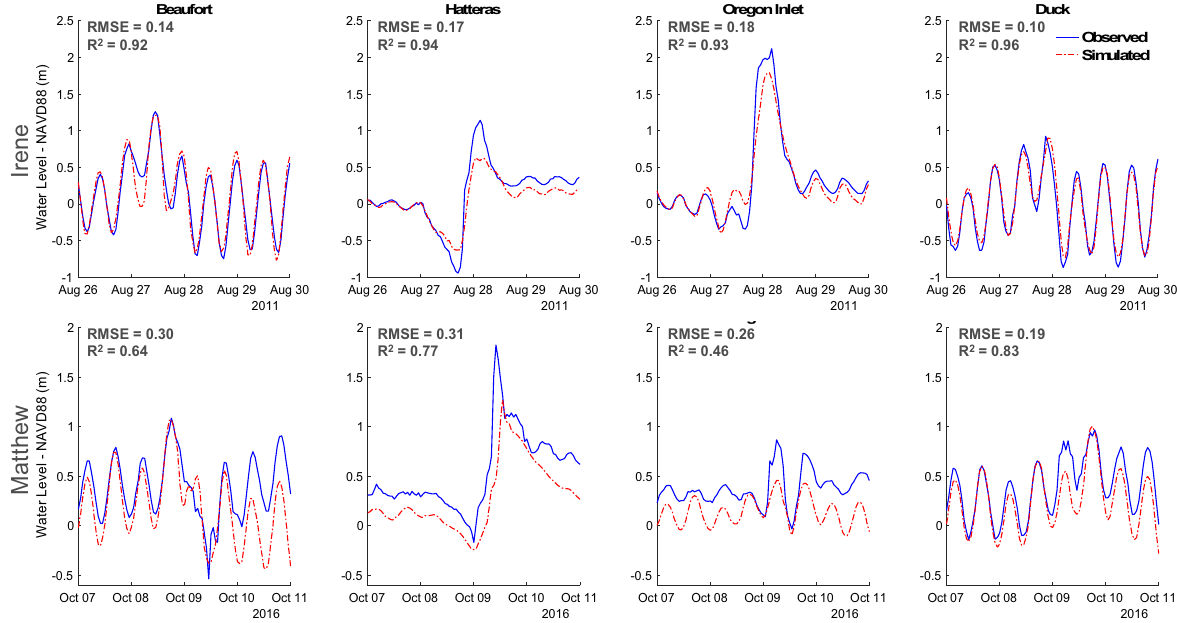
Figure 4. Model validation against NOAA water level gages. RMSE and correlations computed across storm periods, Irene (August 26 0Z–August 30 0Z) and Matthew (October 7 0Z–October 11